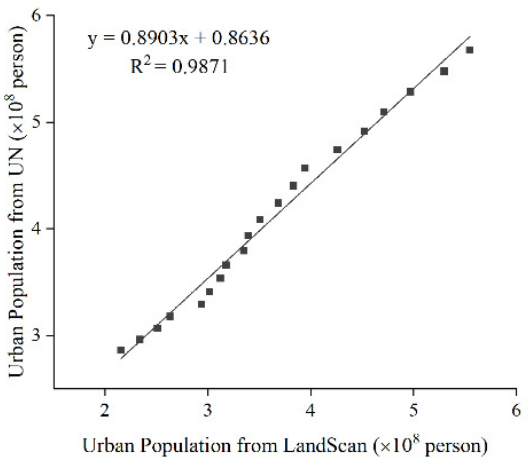
Figure 5. Comparison between urban population obtained from UN and LandScan. For urban land generated from LandScan, we verified it from both qualitative and quantitative perspectives. Figure 6 depicts the qualitative comparison of urban land generated from LandScan (Figure 6d) with land use maps from The Atlas of Urban Expansion (2016 Edition) (Figure 6a) and MCD12Q1 (Figure 6b), and spatial distribution maps